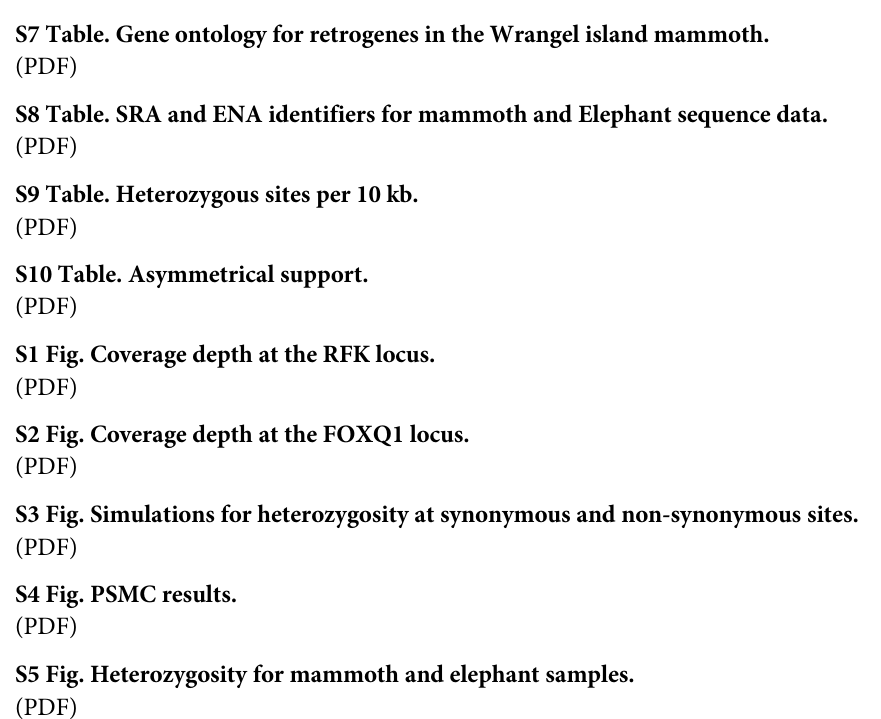
S6 Table. Gene ontology for retrogenes in the Oimyakon mammoth. (PDF) S7 Table. Gene ontology for retrogenes in the Wrangel island mammoth. (PDF) S8 Table. SRA and ENA identifiers for mammoth and Elephant sequence data. (PDF) S9 Table. Heterozygous sites per 10 kb. (PDF) S10 Table. Asymmetrical support. (PDF) S1 Fig. Coverage depth at the RFK locus. (PDF) S2 Fig. Coverage depth at the FOXQ1 locus. (PDF) S3 Fig. Simulations for heterozygosity at synonymous and non-synonymous sites. (PDF) S4 Fig. PSMC results. (PDF) S5 Fig. Heterozygosity for mammoth and elephant samples. (PDF) S6 Fig. Asymmetric SNPs. (PDF) S7 Fig. Asymmetric SNPs, excluding damage. (PDF) S1 Data. SuppFiles.zip—Data release archive.